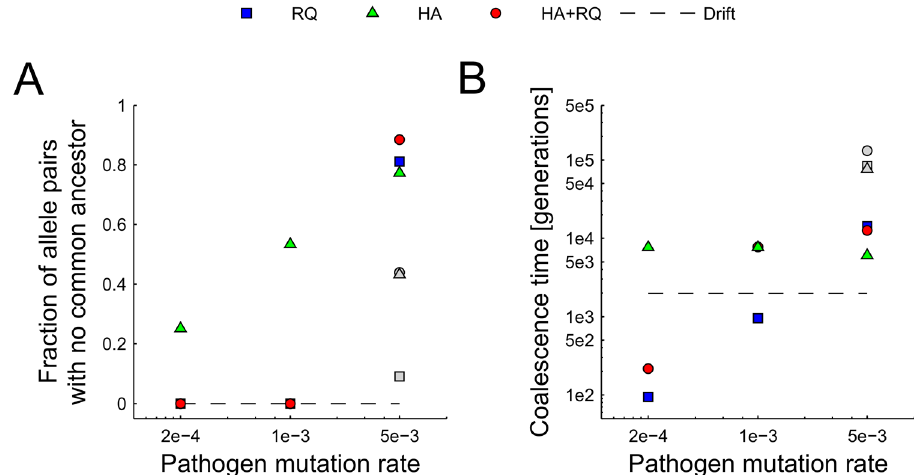
Fig 5. Persistence of MHC allelic lineages. (A) Fraction of allele pairs with no common ancestor within 40 000 generations (red, green, and blue symbols) and 250 000 generations (gray symbols, run only for the highest mutation rate of 5e -3 ) and (B) coalescence times for studied scenarios given in the legend (HA – heterozygote advantage, RQ – Red Queen, HA+RQ –